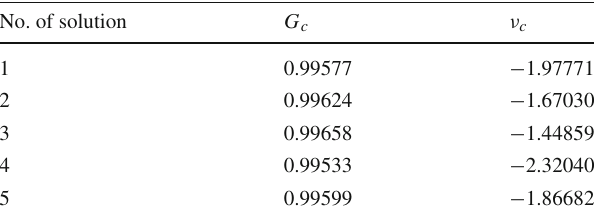
Table 2 Initial conditions for five interior solutions for G (cid:5) ( r = 0 ) =